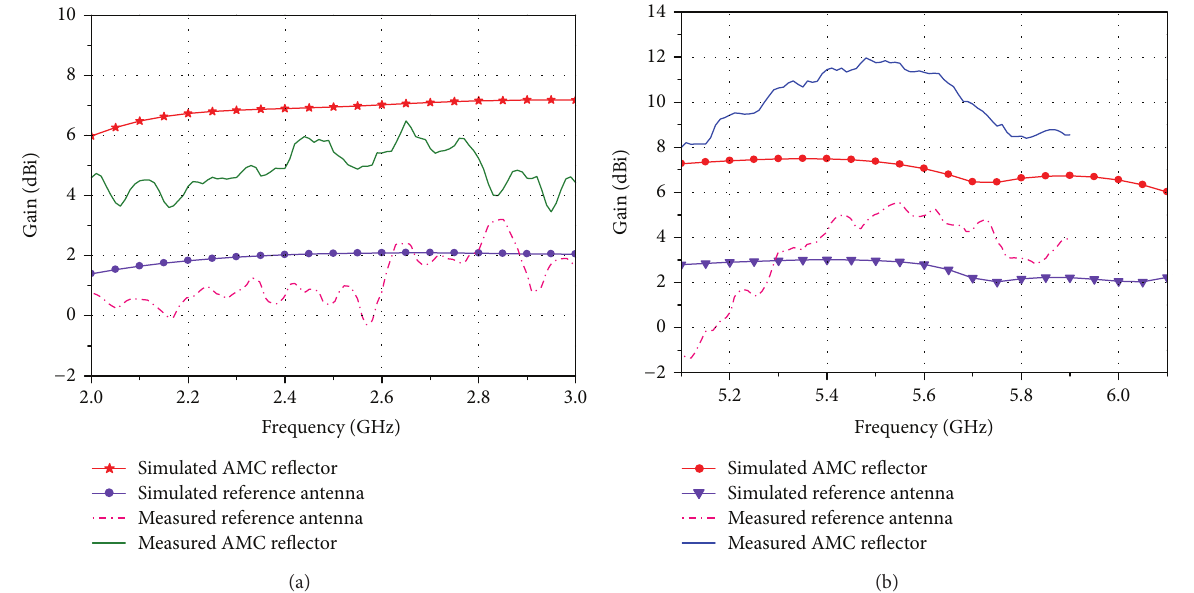
Figure 14: Measured and simulated gain for the reference design and final design (a) 2.45 GHz frequency range, (b) 5.8 GHz frequency